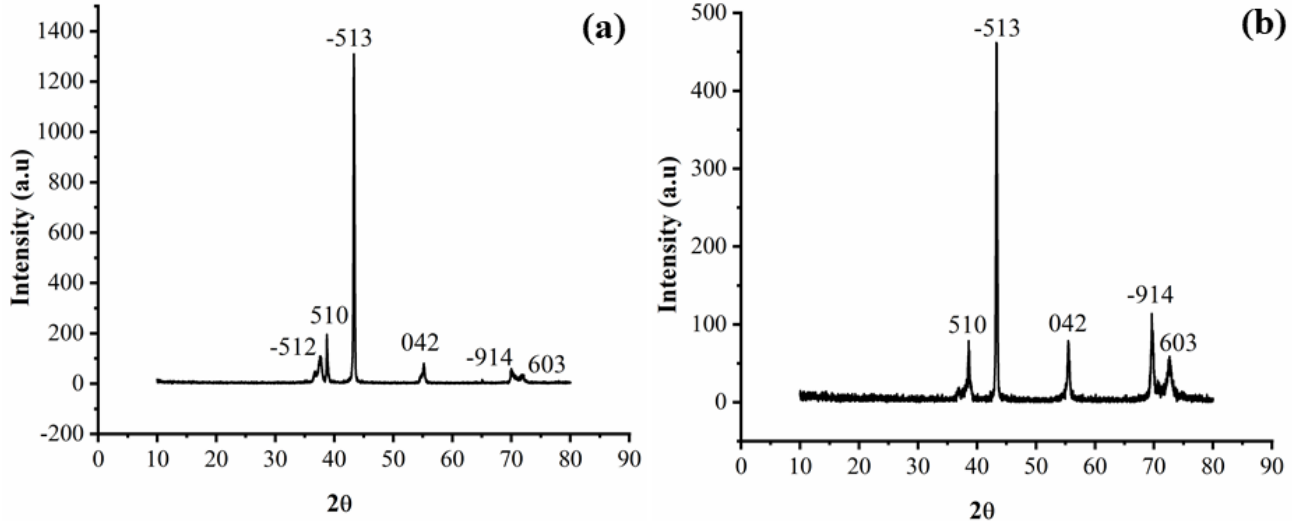
Figure 5. XRD pattern: ( a ) Zn–Ni alloy and ( b ) Zn–Ni–WC composites nanocoating.